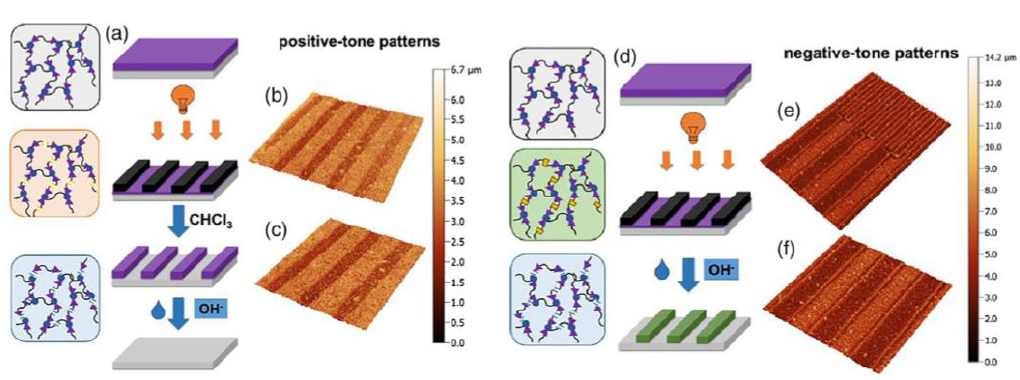
Figure 17. Schematic representation of the formation of a positive-tone resist and ( a ) subsequent removal of the resist by hydrolytic degradation of the PDMS network. ( b and c ) Confocal micrographs of positive-tone relief structures (100 µ m lines and spaces) inscribed into PDMS-1 by photolithography after the development in chloroform. ( d ) Schematic representation of the formation of a negative-tone resist. ( e and f ) Confocal micrographs of negative-tone relief structures (50 and 100 µ m lines and spaces) inscribed into polymer network by photolithography after the development in 1 M aqueous NaOH (Reprinted with permission from reference [134]).